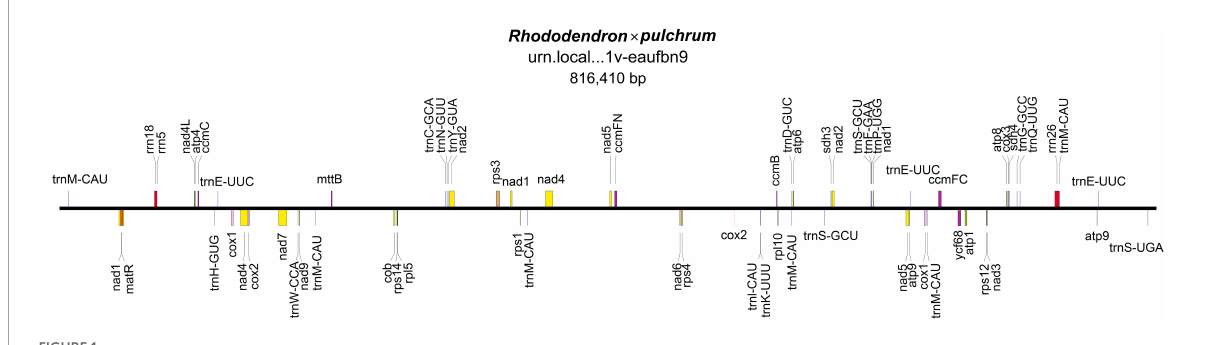
FIGURE1 Gene map of the Rhododendron × pulchrum mitochondrial